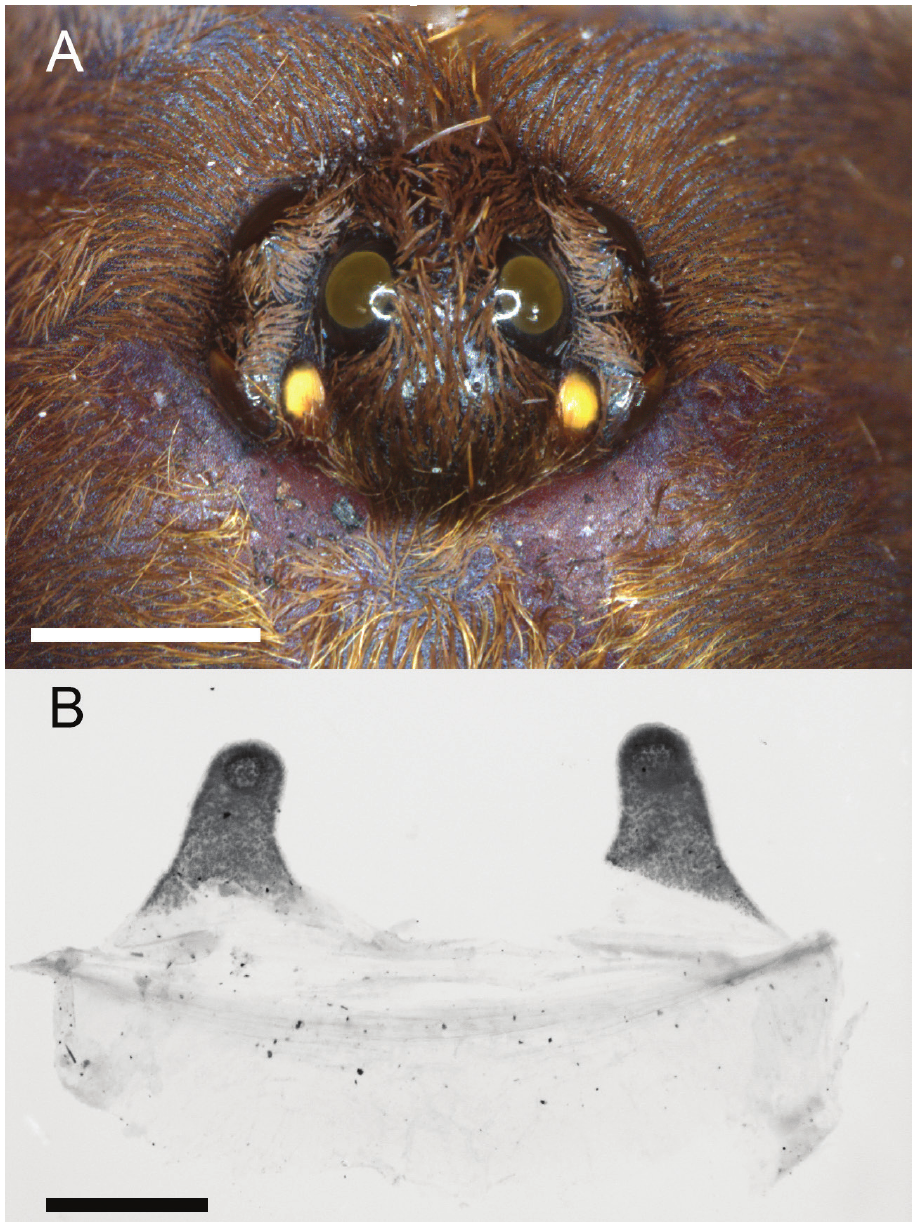
Figure 4. Ceratogyrus attonitifer sp. n. paratype. A ocular tubercle showing eye pattern B spermathecae. Scale bars: 1 mm ( A ); 0.5 mm ( B ).